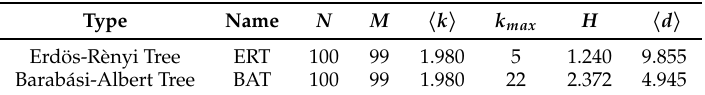
Table 2. Basic topological properties of two tree networks. Where N , M represent the number of nodes and edges respectively, (cid:104) k (cid:105) and k max denote the average degree and maximum degree respectively, H means index of degree heterogeneity in network and (cid:104) d (cid:105) is the mean shortest path in